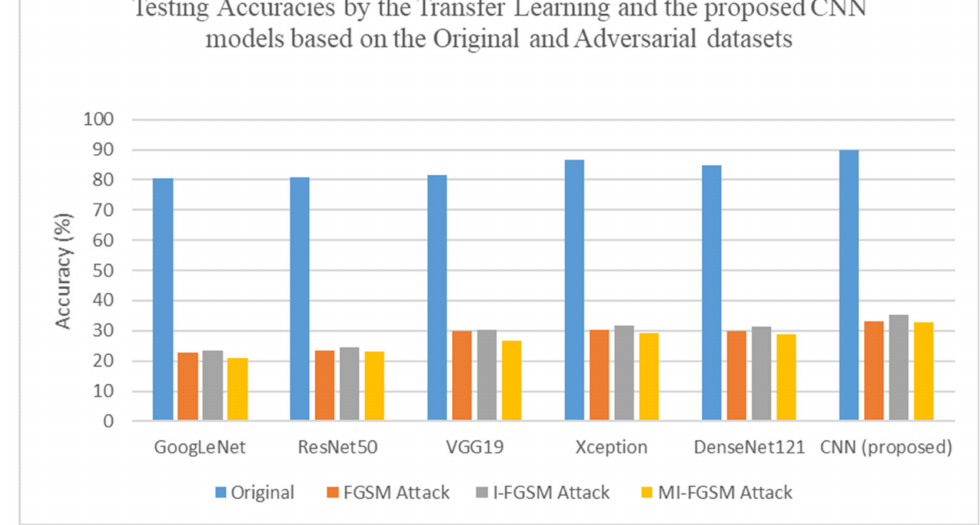
Figure 15. Comparison results of the testing accuracies obtained by the transfer learning and the proposed CNN solver models based on the original and the adversarial text-based CAPTCHA